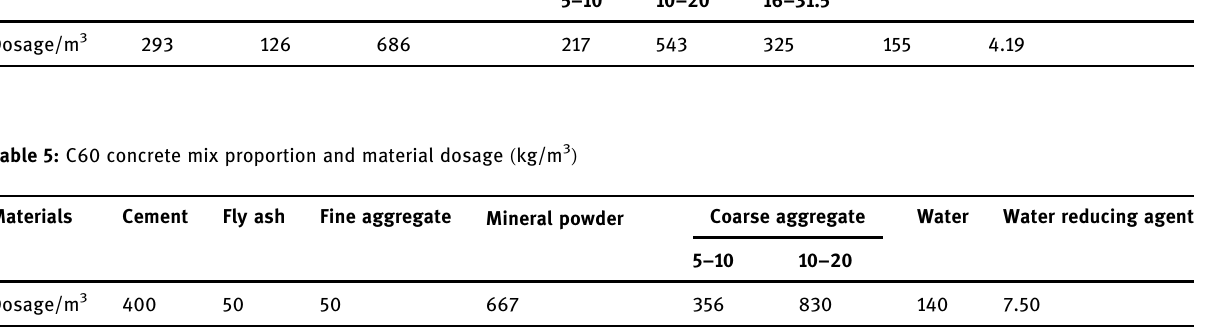
Materials Cement